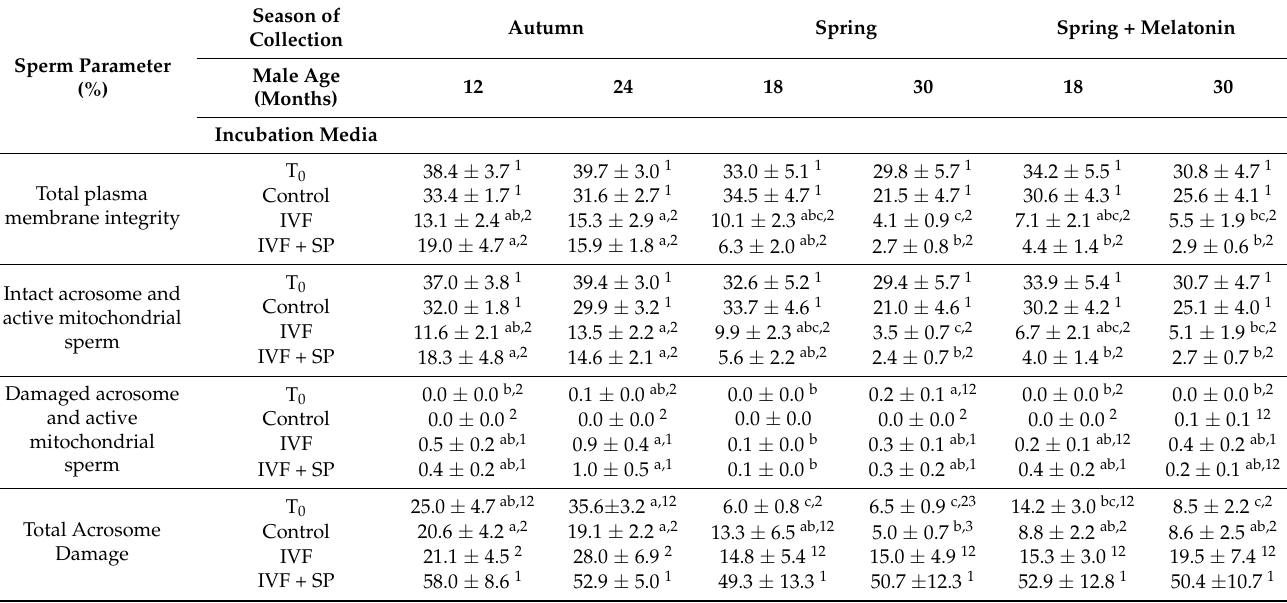
Table 1. Effect of seminal plasma and its resilience under in-vitro capacitation conditions on the viability of thawed buck sperm with respect to male age (months) season, and melatonin implant.